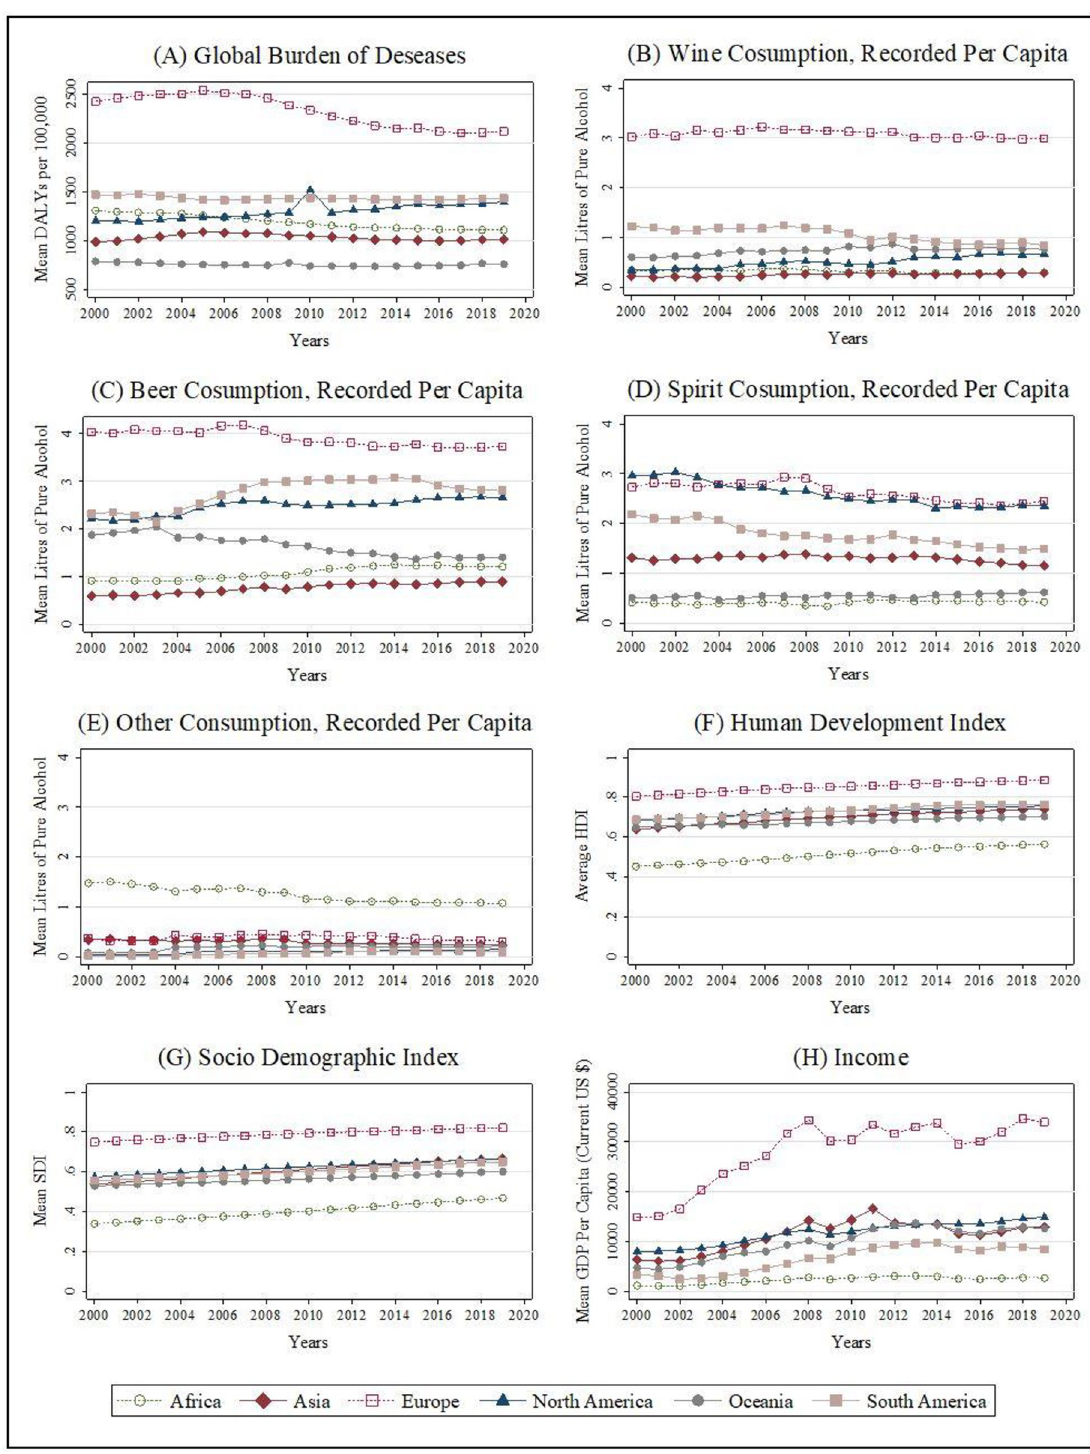
Fig 1. Continent wise averaged variables from 2000 to 2019. Source: Authors’ illustration based on the data.